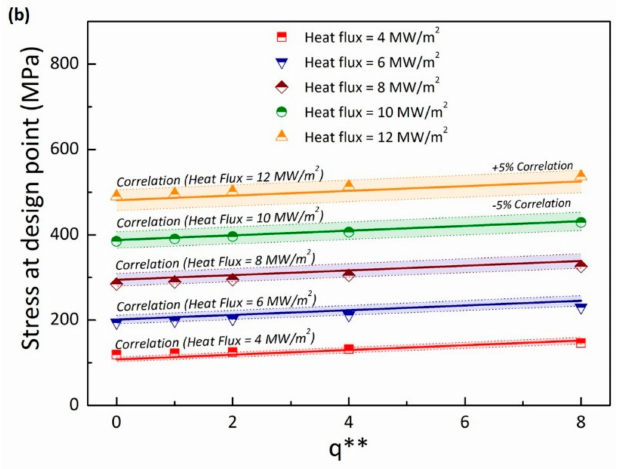
Figure 4. ( a ) Equivalent (Von-Mises) stress distribution due to temperature distribution of divertor module at q * = 1.0 and q ** = 0.0 and ( b ) simulated and correlated results of maximum thimble stress of divertor module with change in normalized heat flux ( q *) and heat generation ( q